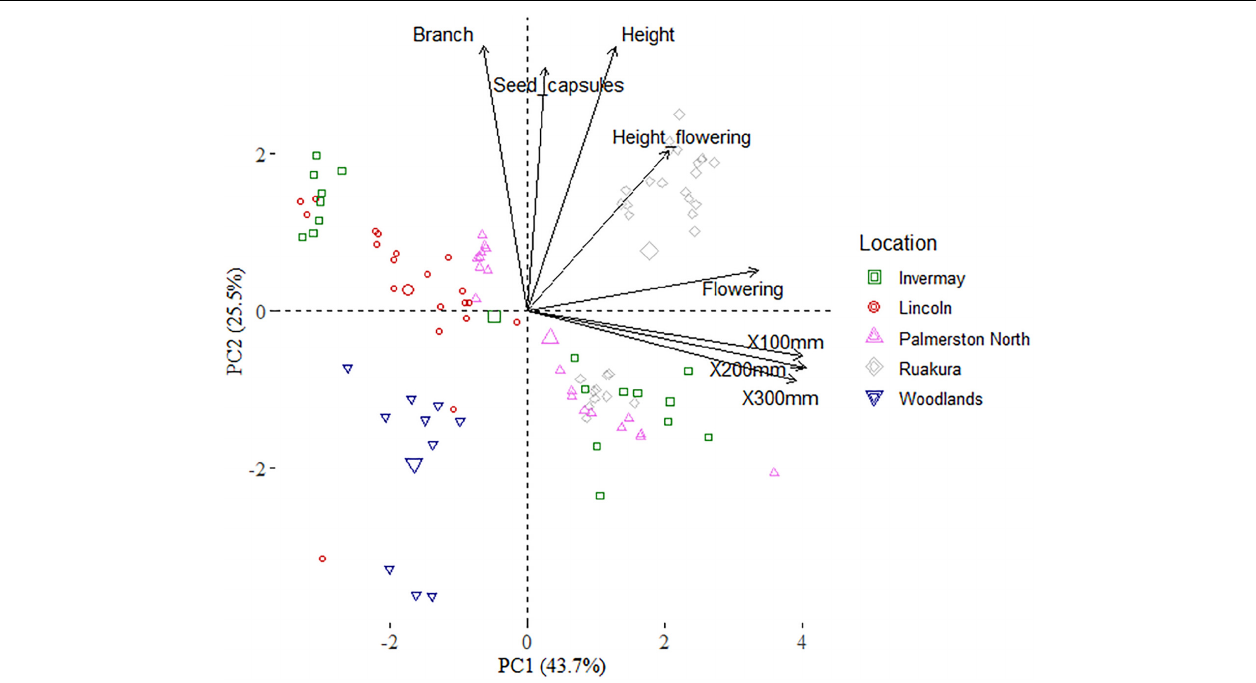
FIGURE 9 | Biplot based on the first two dimensions of the principal component analysis (PCA) of the casual and naturalized populations of A. theophrasti in five different regions of New Zealand. Branch = number of branches, Seed_capsules = number of seed capsules, Height = plant final height, Flowering height = plant height at flowering, Flowering = thermal time required to initiate flowering, X100-300 mm = thermal time required to reach a plant height of 100–300 mm.